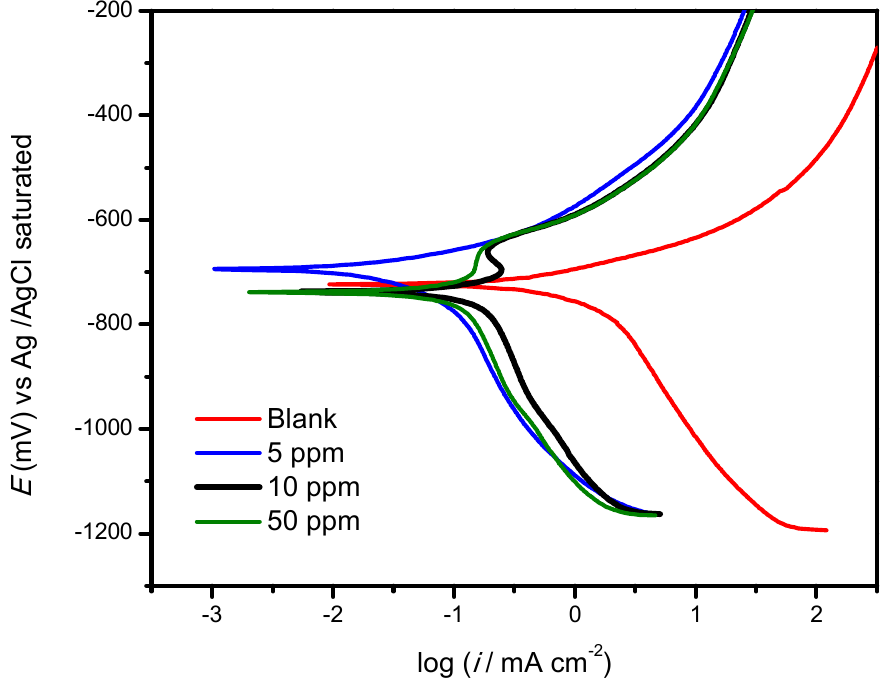
Figure 9. Polarization curves of 4-PC in AISI 1018 steel immersed in 3% NaCl + CO 2 . On the other hand, when the concentration increased, both anodic and cathodic curves moved towards the lower current density. This phenomenon implies that the